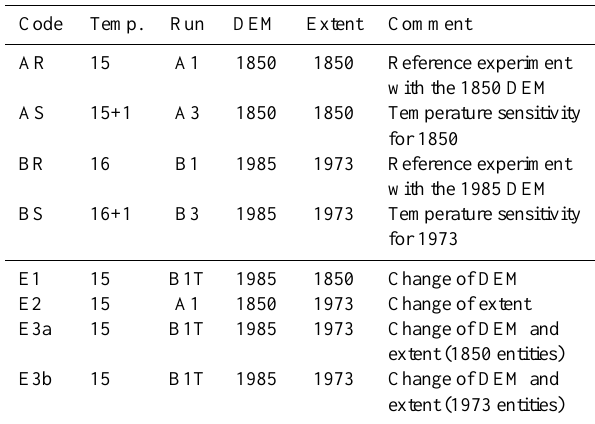
Table 2. Overview of the glacier extents used for spatial averaging of the calculated mass balance from the model runs listed in Table 1 (column “Run”). Code